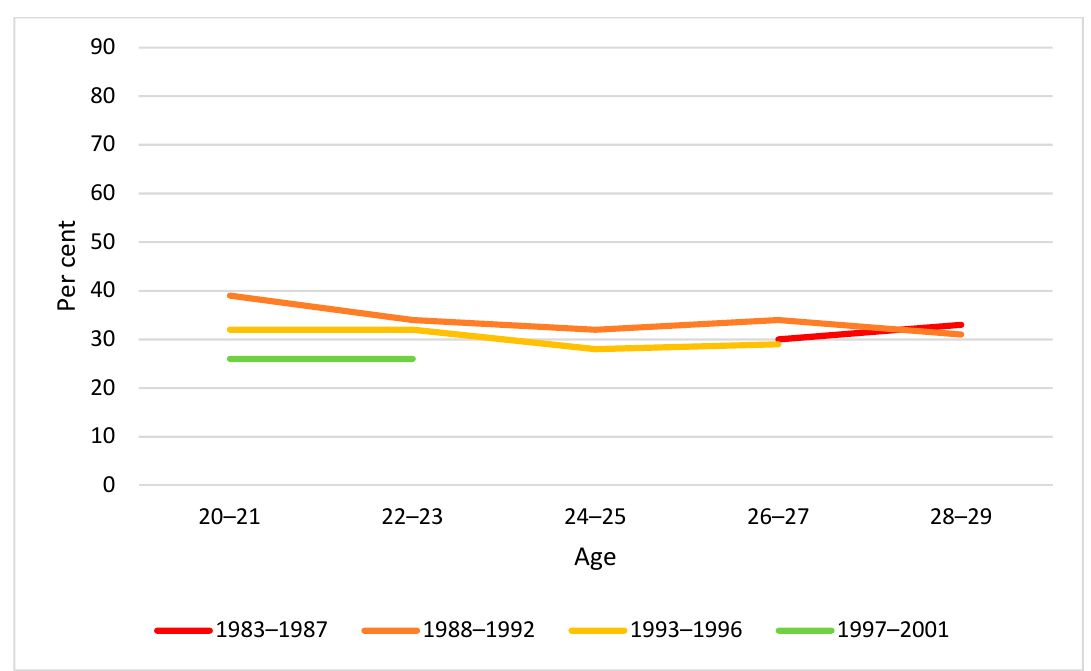
Figure 4. Proportion weekly drinking by birth cohort and age. Note: None of the cohort differences at any age were statistically significant ( p > 0.05).